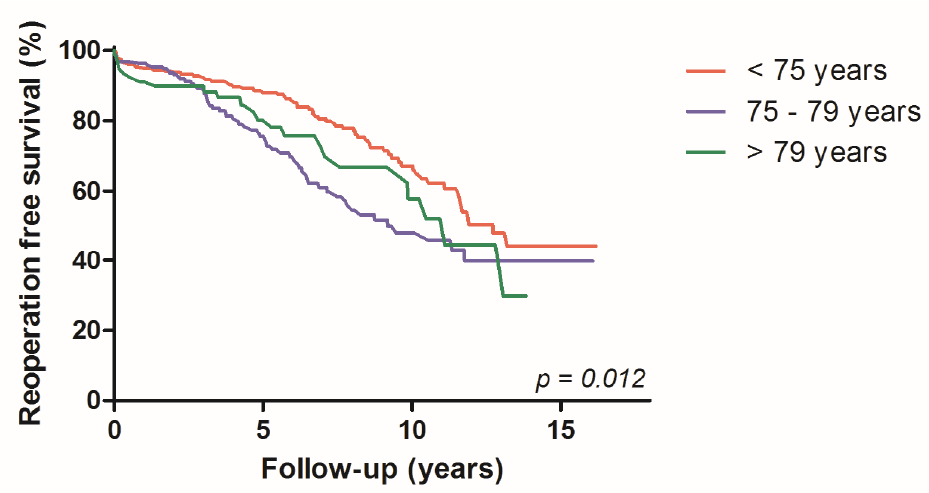
Figure 4. Kaplan-Meier curves: reoperation free survival, according to age groups.